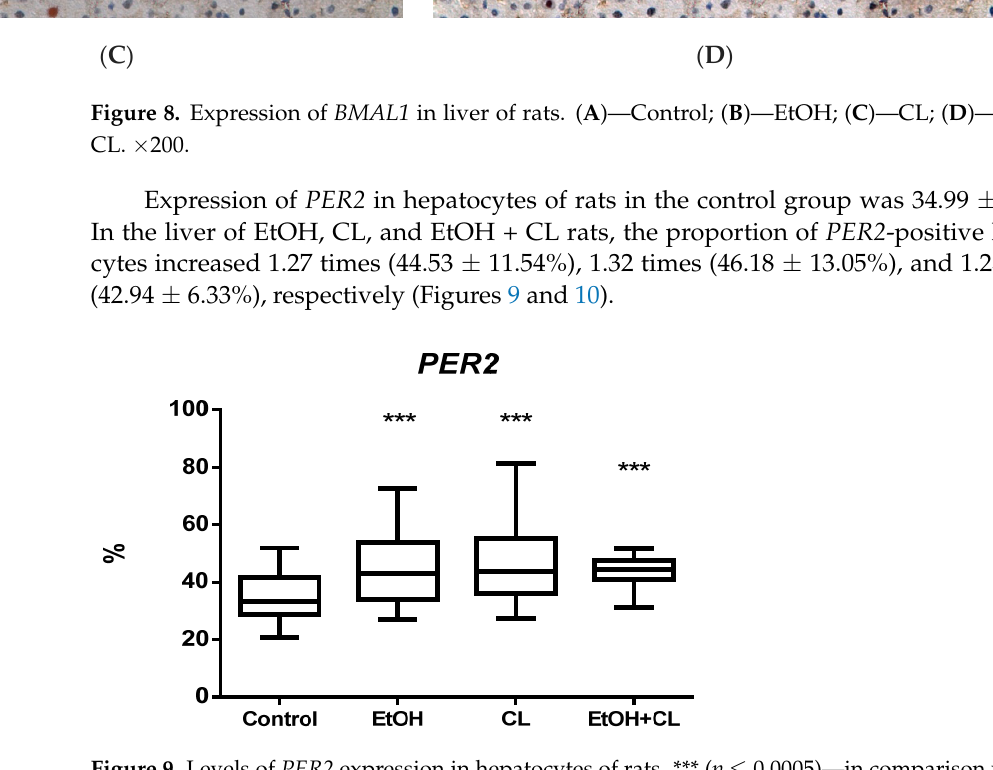
Figure 9. Levels of PER2 expression in hepatocytes of rats. *** ( p ≤ 0.0005)—in comparison with the parameters of animals of the control